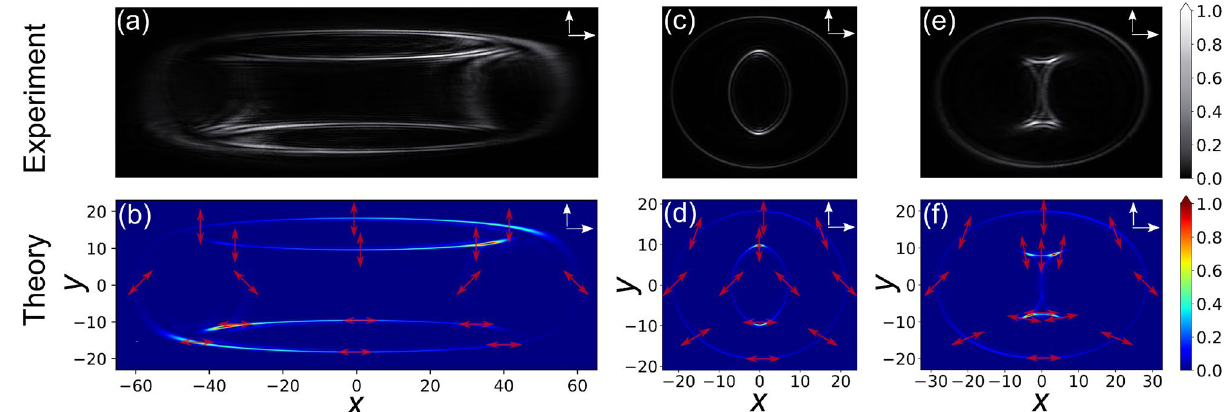
Figure 3. Experimentally observed (upper row) and theoretically calculated (lower row) non-circular CD π/ 2 ) and various combinations of the magnification factors M x and M y . ( a ) patterns for crossed crystals ( γ 2 = 2.50 , M 0.400 , M 0.778 , M 0.233 ; ( c ) + ( d ): M 0.232 ; ( e ) + ( f ): M 0.323 (partially + (b) : M x x = x = y = y = y = = degenerate case). Remaining parameters and symbols as for Fig. 2.